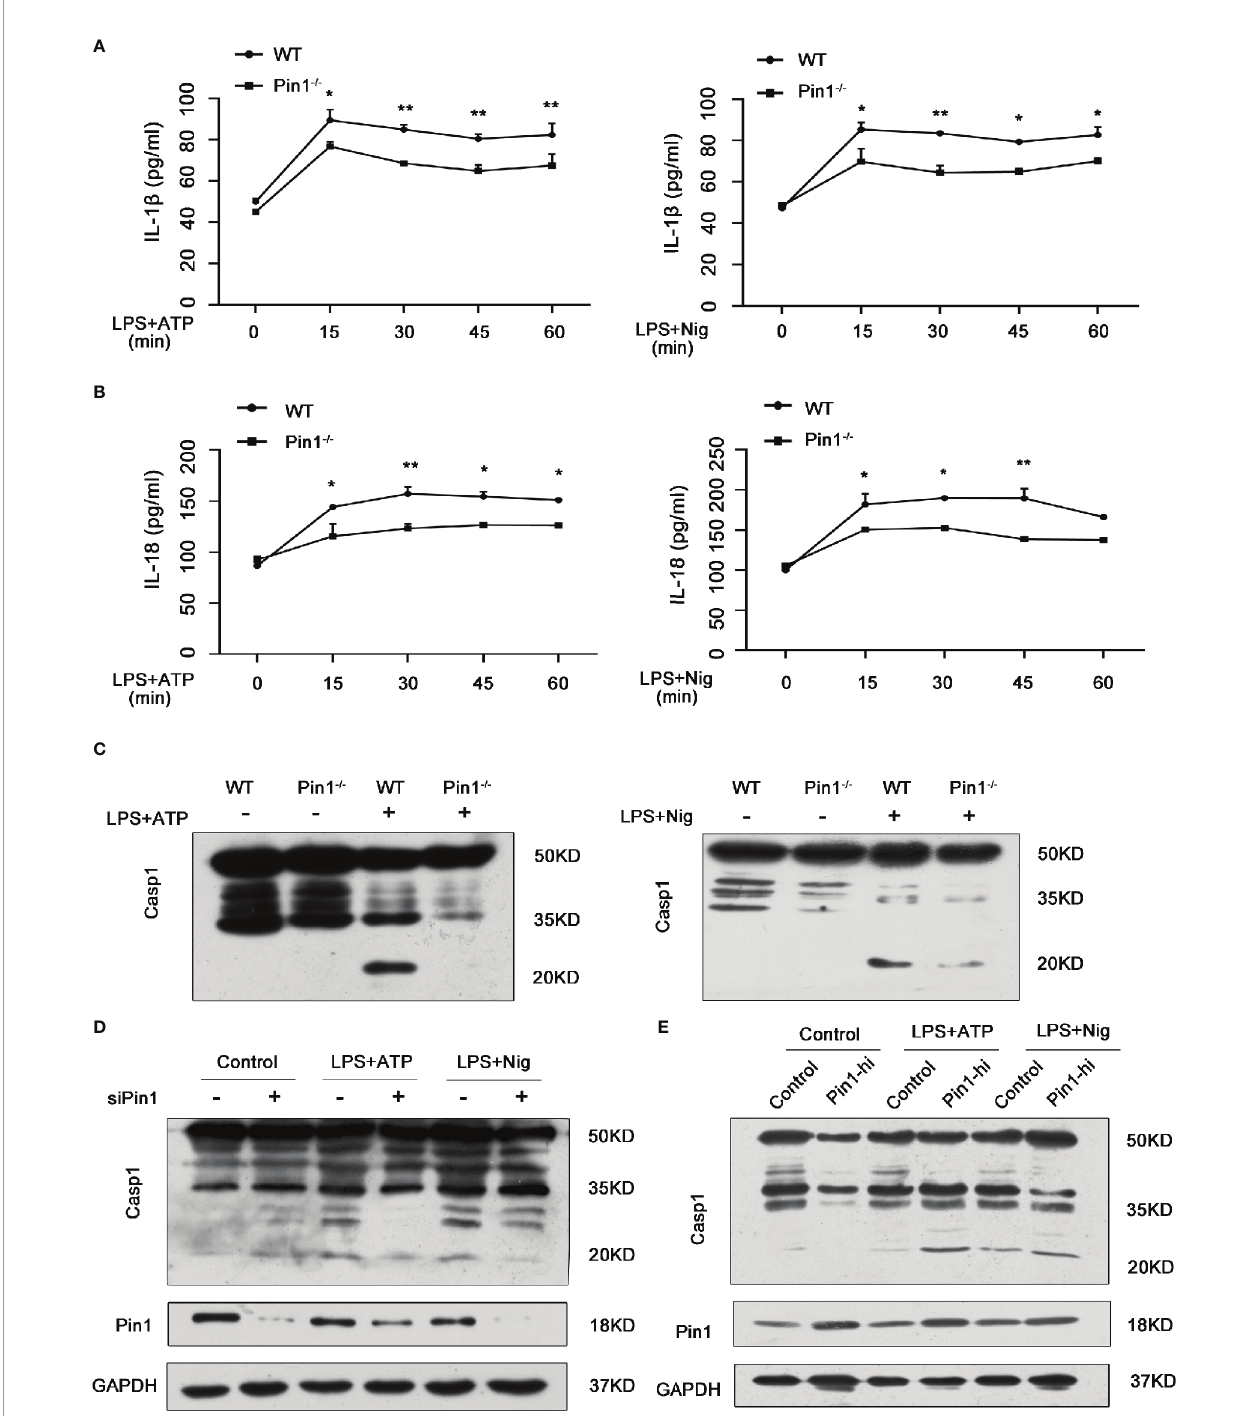
FIGURE 2 | Caspase-1 activation and IL-1 b and IL-18 secretion in macrophages were inhibited in Pin1 -/- mice. (A, B) WT and Pin1 -/- bone marrow-derived macrophages (BMDMs) were primed with 500 ng/ml lipopolysaccharide (LPS) for 4 h and stimulated with ATP or nigericin for different lengths of time, supernatants were analyzed for IL-1 b and IL-18. (C) WT and Pin1 -/- BMDMs were primed with 500 ng/ml LPS for 4 h and then stimulated with 5mM ATP or 20 mM nigericin for 30 min. Lysates were immunoblotted for caspase-1. (D) RAW 264.7 cells transfected with control siRNA or siRNA for Pin1 were primed with 500 ng/ml LPS for 4 h and then stimulated with 5 mM ATP or 20 mM nigericin for 30 min. Lysates were immunoblotted for caspase-1. (E) RAW 264.7 cells with high Pin1 expression (Pin1-hi) were primed with 500ng/ml LPS for 4h and then stimulated with 5 mM ATP or 20 mM nigericin for 30 min. Lysates were immunoblotted for caspase-1. The data represent the mean ± SD of one among three biological replicates, with three technical replicates each. *P < 0.05; **P < 0.01, two-way ANOVA (A, B)